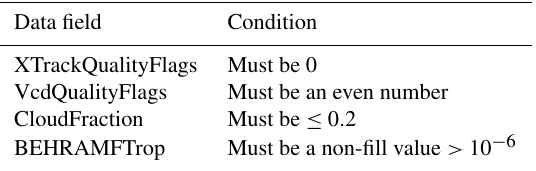
Table 1. Criteria that OMI pixels must meet to be used in any com-